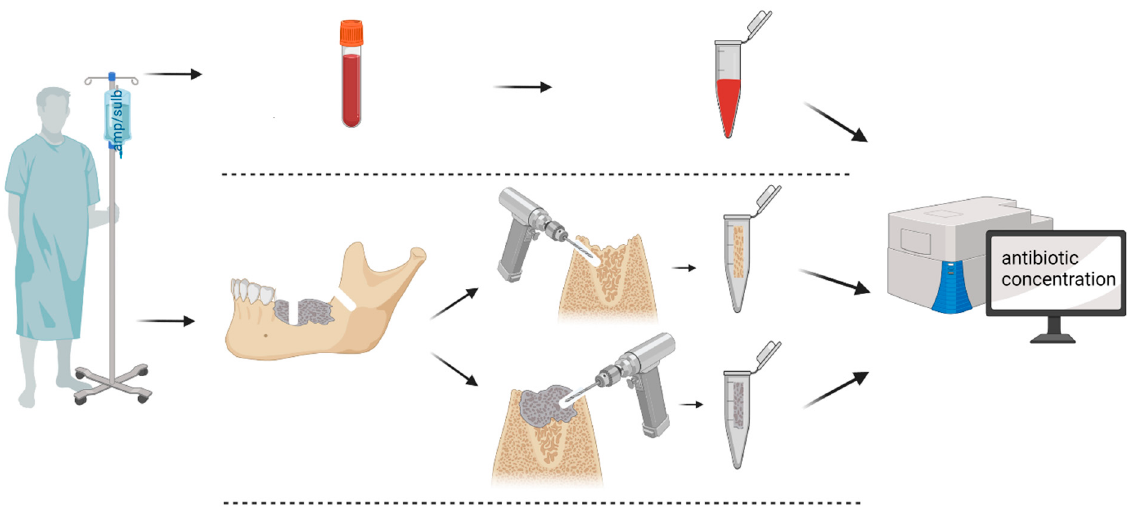
Figure 3. Ampicillin/sulbactam was administered to each patient intravenously on admission to hospital. This routine was started one day before surgery. Ampicillin/sulbactam was again administered as perioperative prophylaxis ten minutes before the plasma blood sample was taken. Bone samples were normally obtained within 60 min after antibiotic injection, depending on the surgical process. The necrotic sample was taken from the center of the ONJ, and the vital sample from the surrounding healthy bone tissue. The samples were further processed as described above.